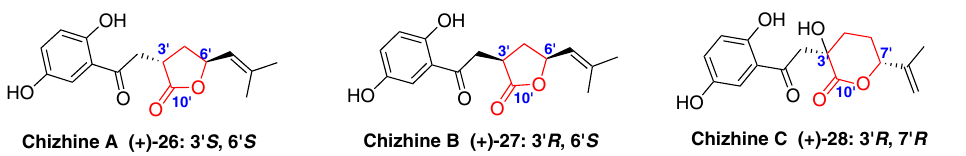
Fig. 2 Structures of GMs with a c -lactone